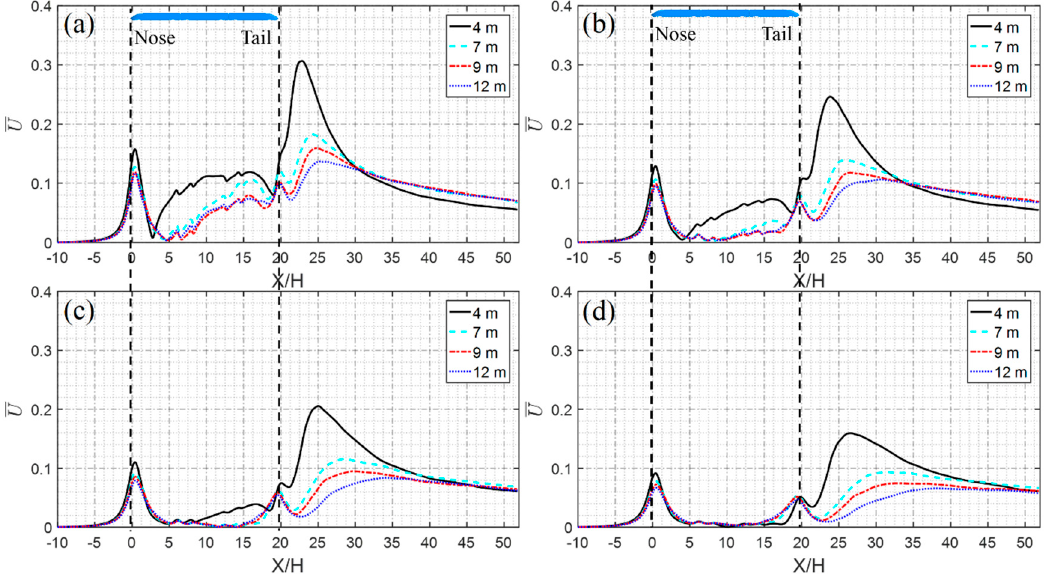
Figure 10. Time-averaged U of different nose lengths at height z = 0.2 m from TOR for ( a ) y = 2.5 m, ( b ) y = 3 m, ( c ) y = 3.5 m, and ( d ) y = 4 m (black dashed line on left is the nose and that on right the tail).